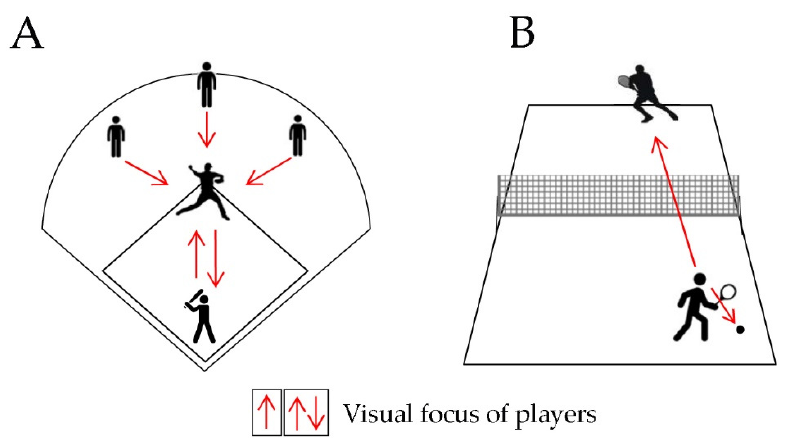
Figure 1. Representative models of baseball ( A ) and tennis ( B ) fields, players, and match development. The arrows indicate the visual burden: ( A ) the two-way arrows between the pitcher and the batter show the mutual visual focus before and during the throw action of pitcher; the outfield players wait for the throw development (arrows directed from outfield players to the pitcher); ( B ) the visual burden is limited to the ball and the opponent’s movements (both arrows from the player directed to the ball and the opponent).